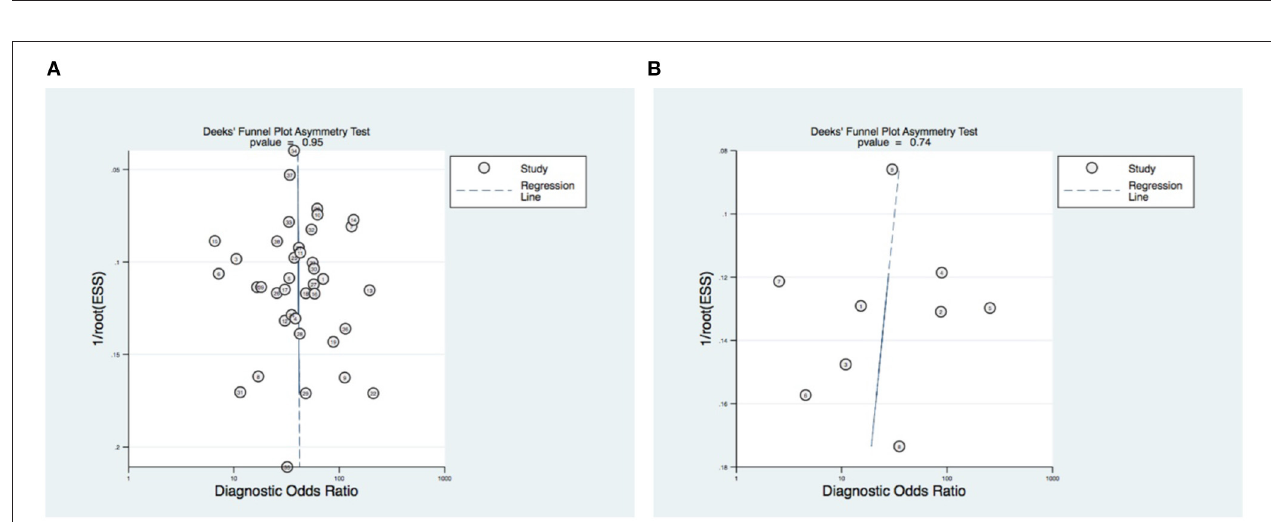
FIGURE 5 | Univariable meta-regression and subgroup analysis of (A) pCMR and (B) DSE. CI, confidence intervall.